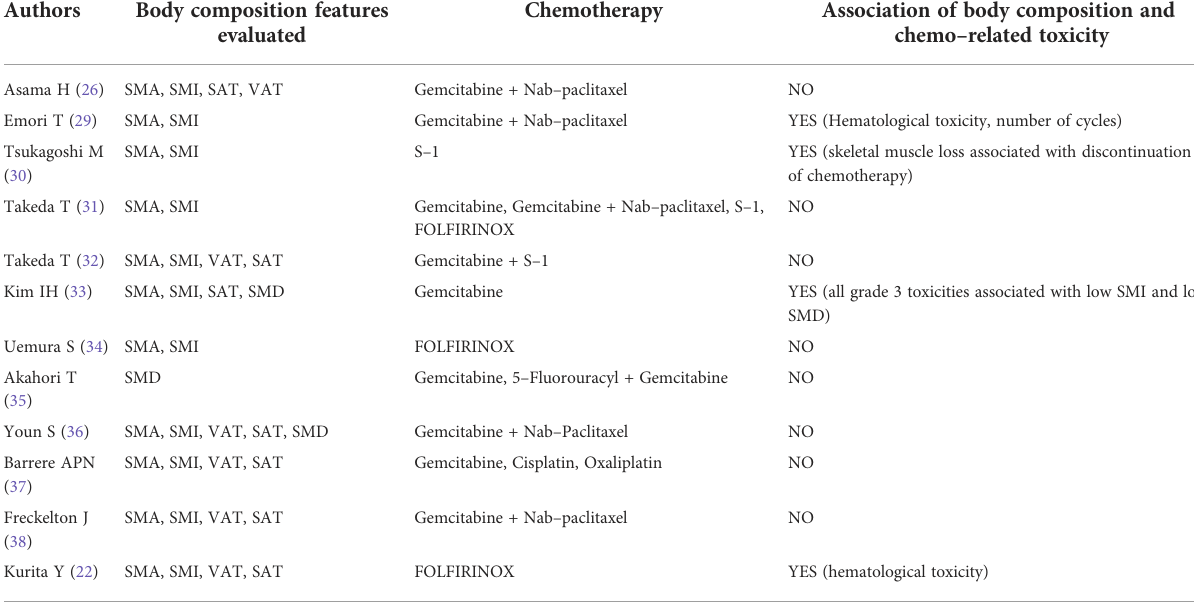
TABLE 3 Body composition features evaluated, chemo – related toxicities encountered and their association (if any).